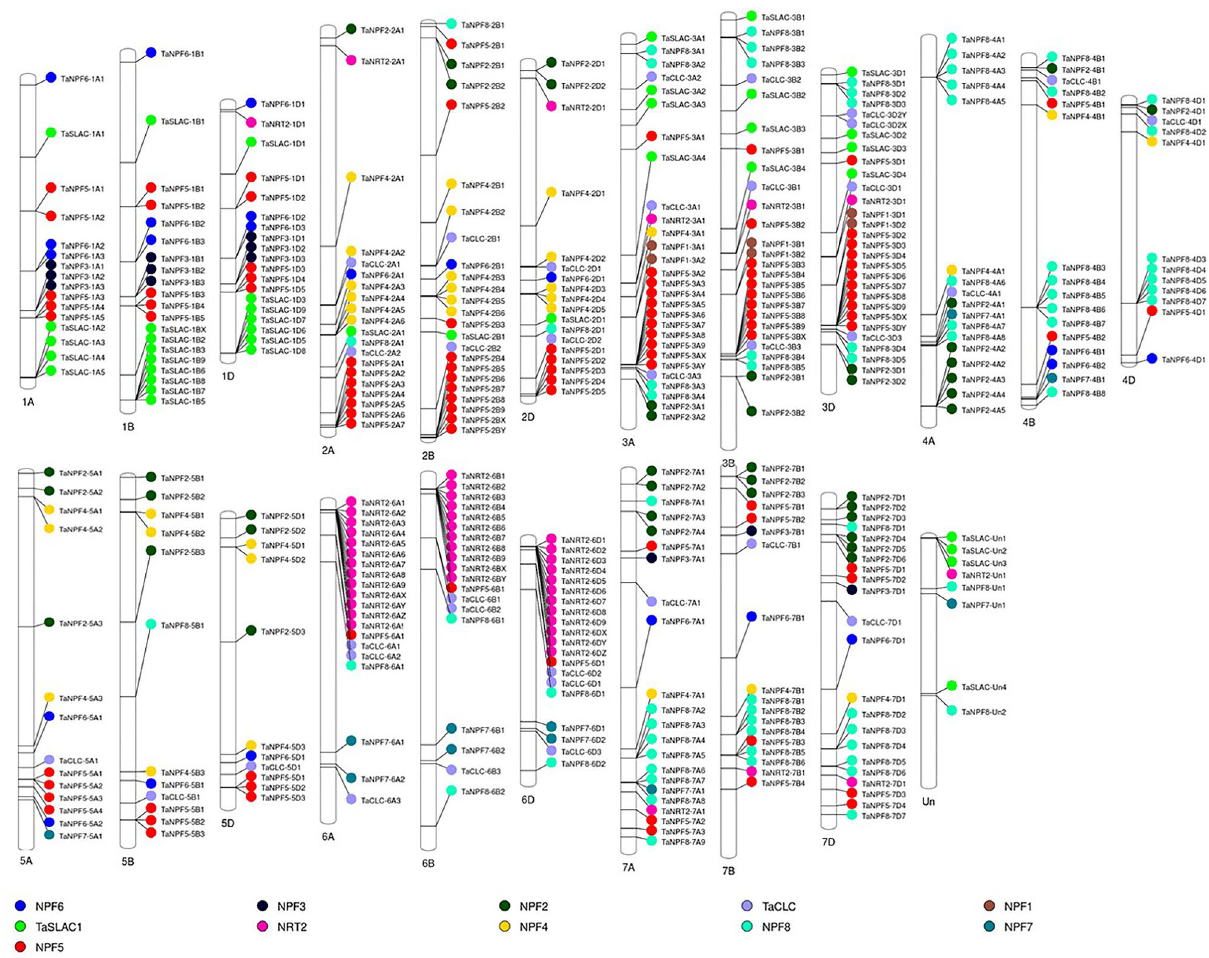
Figure 1. Genome wide distribution of TaNPF , TaNRT2 , TaCLC and TaSLAC1/TaSLAH genes in hexaploid wheat. Figure was generated by web-based software tool-Phenogram from Ritchie Lab 44 (http:// visua lizat ion. ritch ielab. org/ pheno grams/